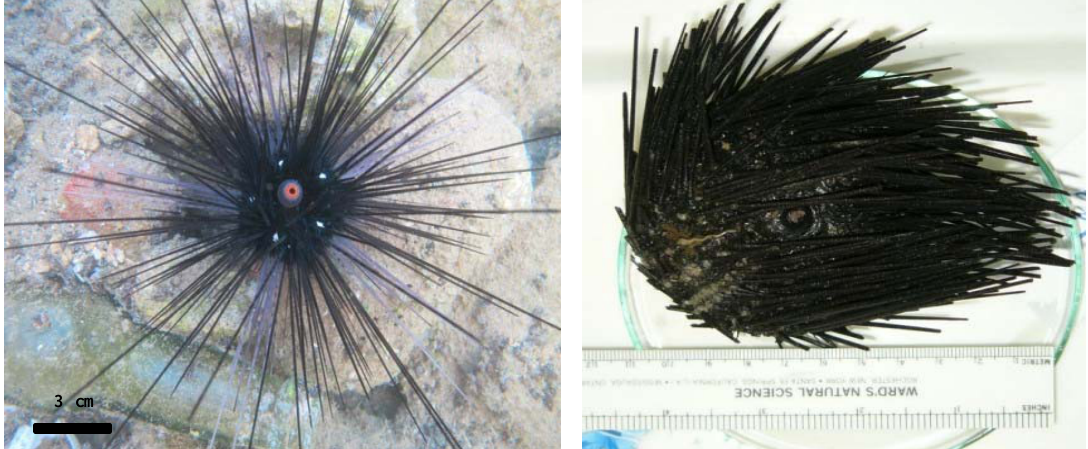
F IGURE 9. Diadema setosum (Leske,